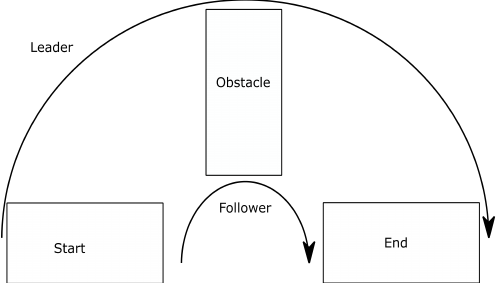
Figure 4. Floor plan, human-human. Sensor Placement